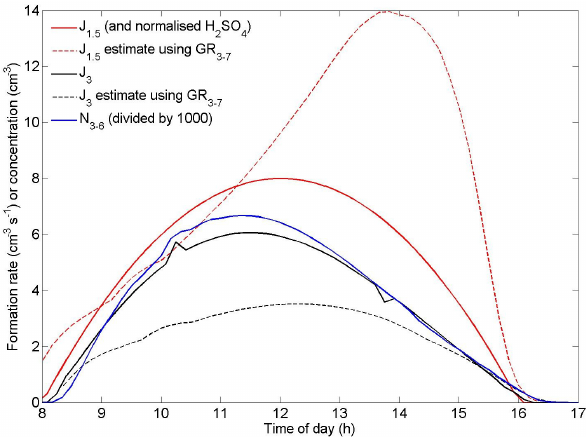
Fig. 2. An example of a simulated activation nucleation event in which N 3 − 6 peaks earlier in the day than H 2 SO 4 and thus the anal- ysis yields a negative time delay 1t N . Also shown are the simu- 3 − 6 lated nucleation and new particle formation rates ( J 1 . 5 and J 3 solid lines) as well as the estimates obtained using a cluster growth rate from lognormal fits to the 3–7nm size range (dashed